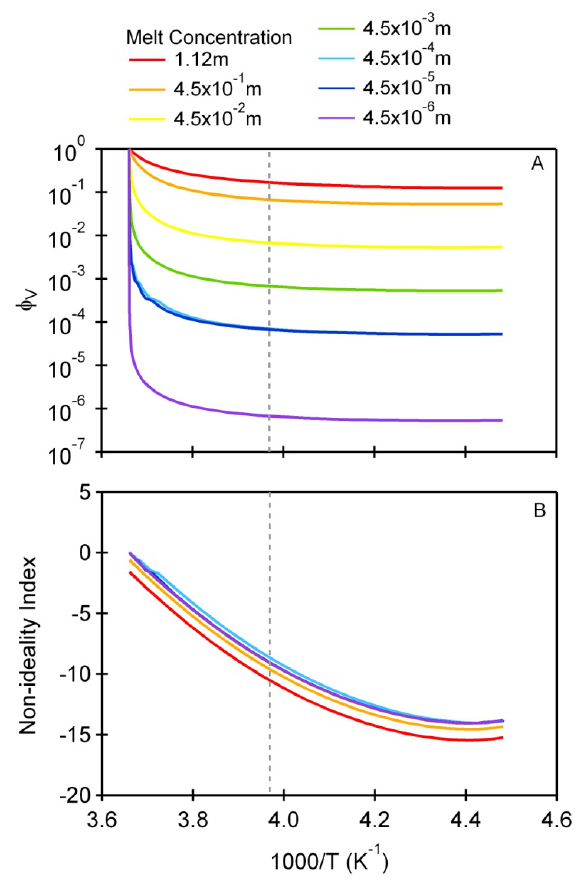
Fig. 1. Calculated (A) brine volume fraction and (B) the non ideal- ity index of the brine layer at different NaCl concentrations in the melt and at a range of temperatures. a given initial concentration, ϕ V decreases gradually as tem- perature drops from T m and then remains fairly constant as it approaches the eutectic temperature, which is marked by the dotted vertical line in Fig. 1. From Fig. 1b, one can see that the effect of non-ideality can become significant, especially at low temperatures and for systems with higher salt